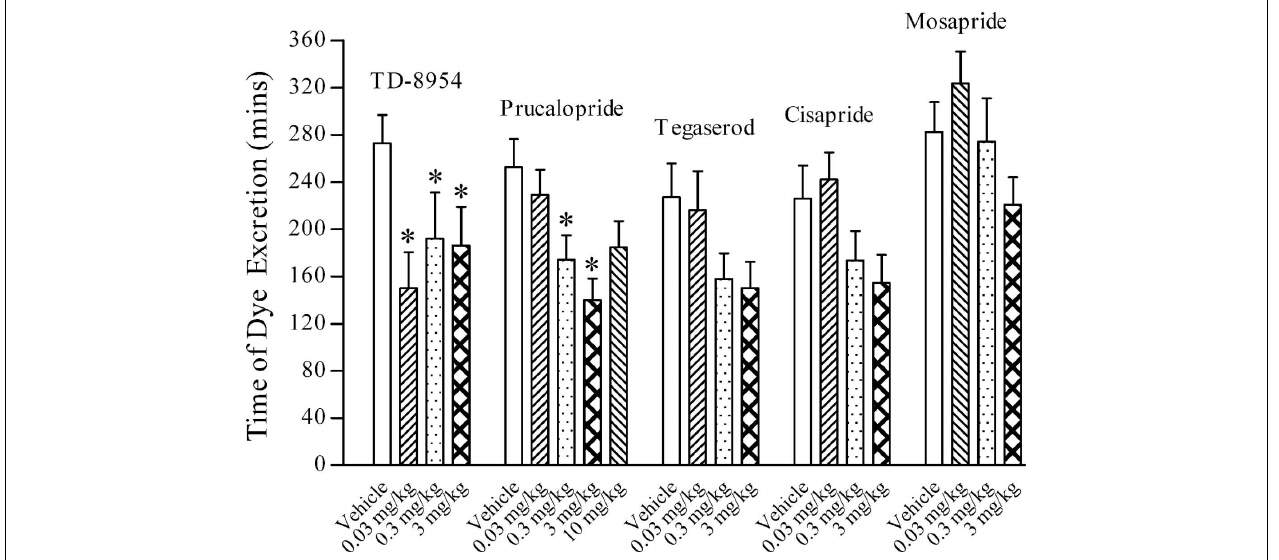
FIGURE 3 |The effects ofTD-8954, tegaserod, cisapride, mosapride (each at 0.03–3mg/kg), prucalopride (0.03–10mg/kg), and vehicle (2mL/kg), administered s.c., on the colonic transit of dye in conscious guinea pigs ( n = 9–22 for each group; * p < 0.05;ANOVA followed by Dunnett’s post hoc test vs. vehicle).